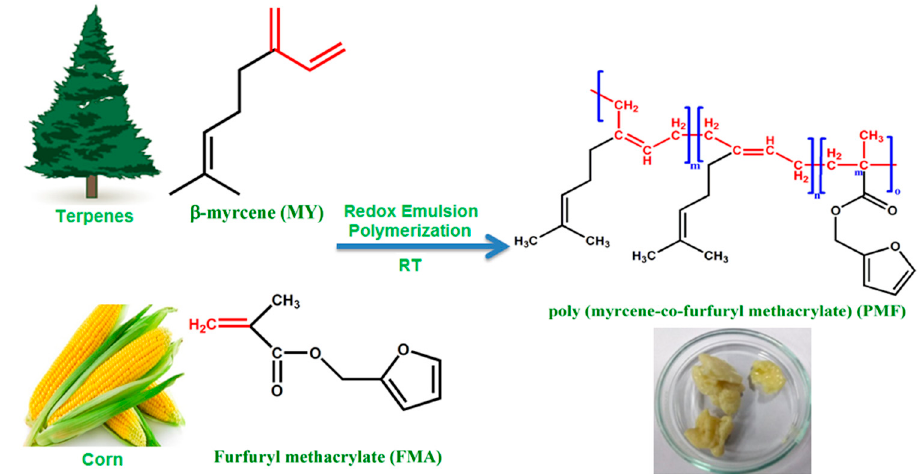
Figure 1. Synthetic routes toward β -myrcene/furfuryl methacrylate copolymers (Reproduced with